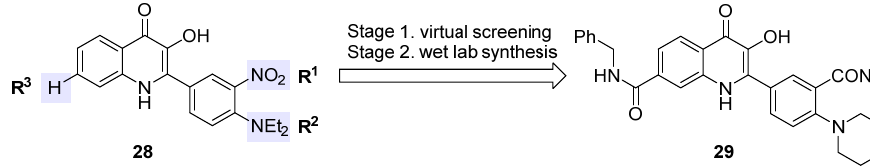
Figure 6. Structures of eEF1A1-targeting anticancer 3-HQ derivative 29 and its prototype 28